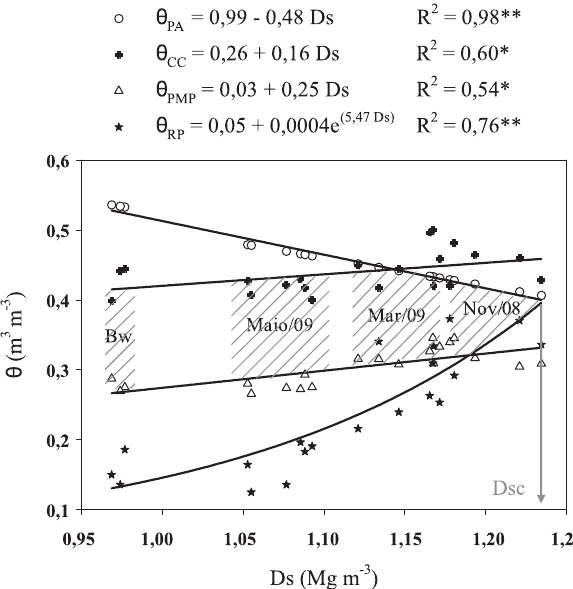
Figura 1. variação do intervalo hídrico ótimo